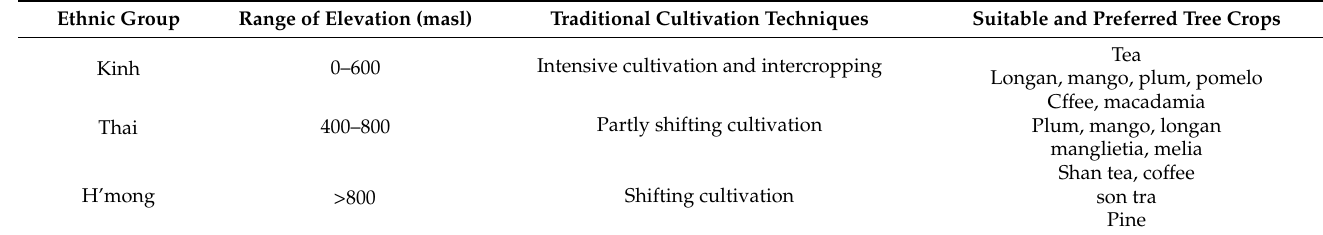
Table 1. Farming characteristics of three ethnic